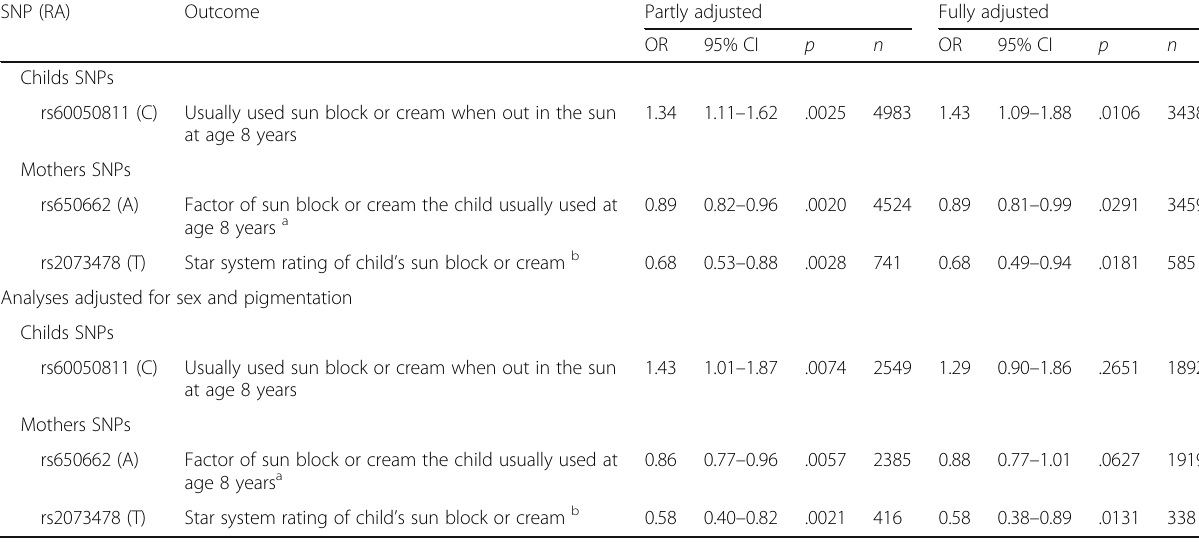
Table 3 Association of tanning dependent related single nucleotide polymorphisms and sun exposure variables SNP (RA)